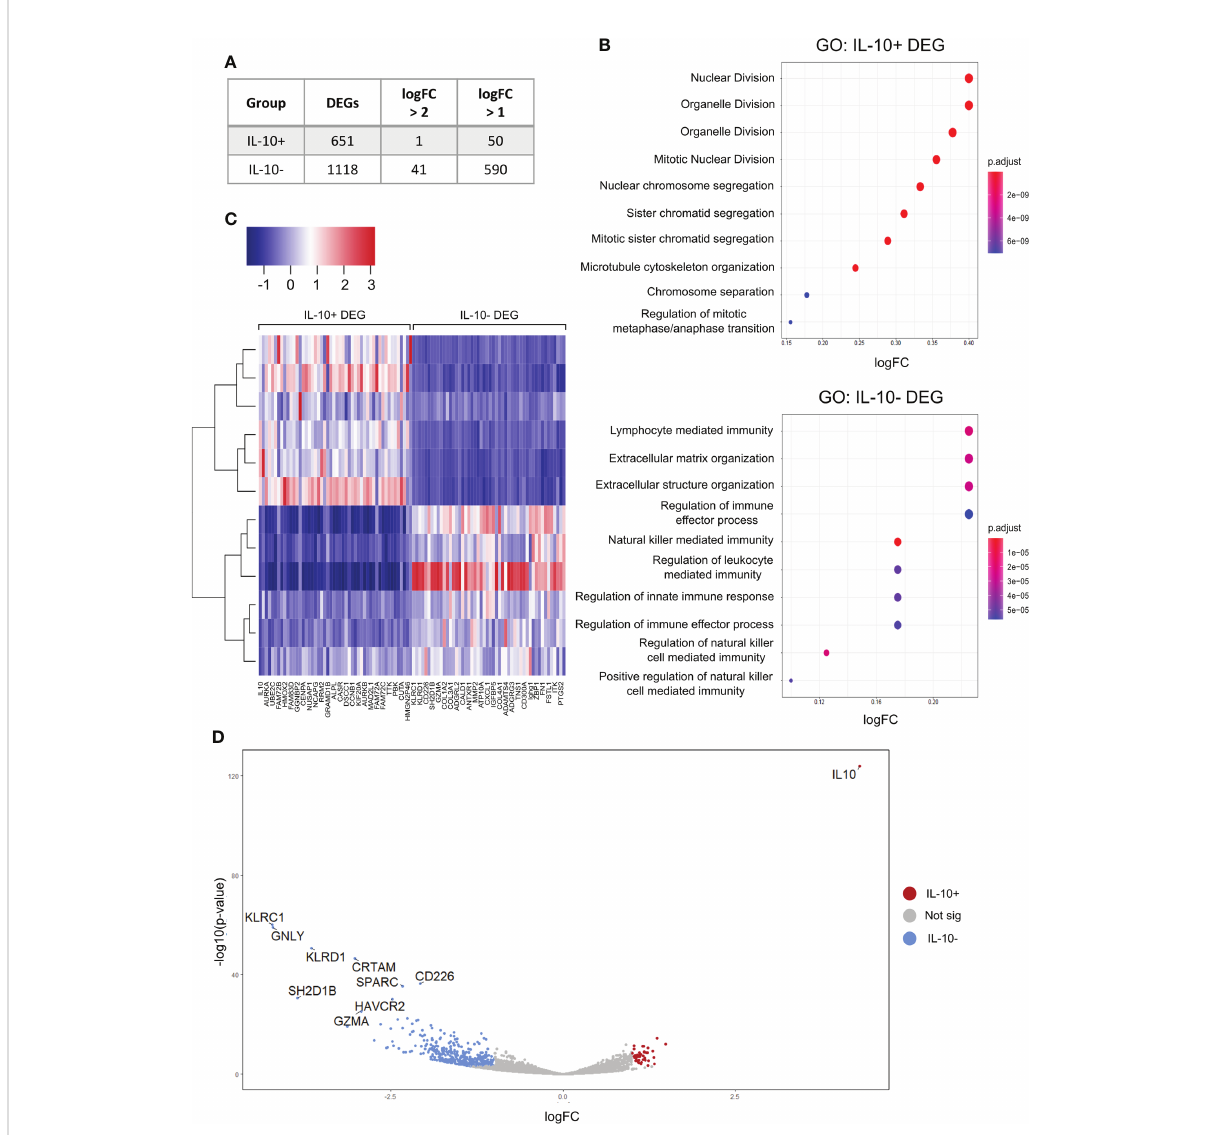
FIGURE 4 RNA-seq analysis of differentially expressed genes (DEG) shows an increased abundance of IL-10- DEG that are involved in extracellular matrix organization and immune regulation. IL-10+ are mainly involved in cellular division and activation. (A) Table shows number of DEG in both groups. We observed a higher relative abundance of IL-10 - DEG (B) Gene ontology analysis of biological processes in IL-10 + and IL-10 - DEG. IL-10 + DEG are enriched in cellular division processes suggesting that IL-10 + iBreg populations do not constitute a particular Breg population. IL-10 - DEG are associated to immune modulation and extracellular matrix organization, suggesting a potential association to Breg functionality and elucidating a possible link between extracellular matrixes and iBreg function. (C) Heatmap of top 20 DEG genes from both groups. (D) Volcano plot of genes identi fi ed by RNA-seq. Top 10 signi fi cant DEG are named on the plot. IL-10 - DEG show higher fold changes and p- values and constitute potential Breg biomarkers, while IL-10 is the only gene identi fi ed in IL-10 + populations with higher signi fi cance and fold change. Colored dots represent signi fi cant genes (p-value < 0.05) with a logFC value of ±